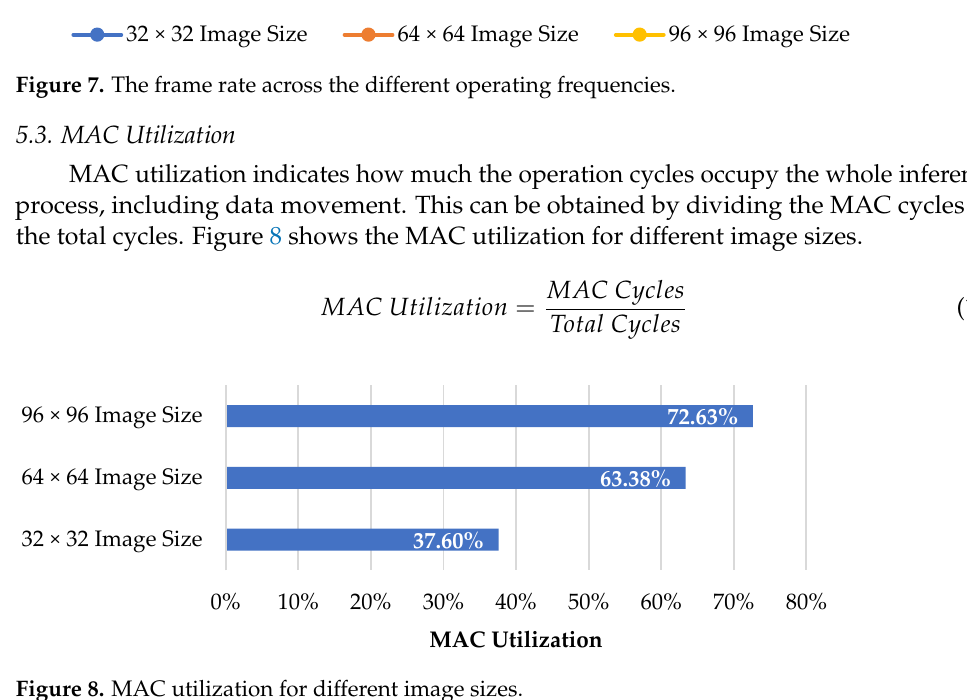
(18) Figure 9. Power consumption across the different operating frequencies.